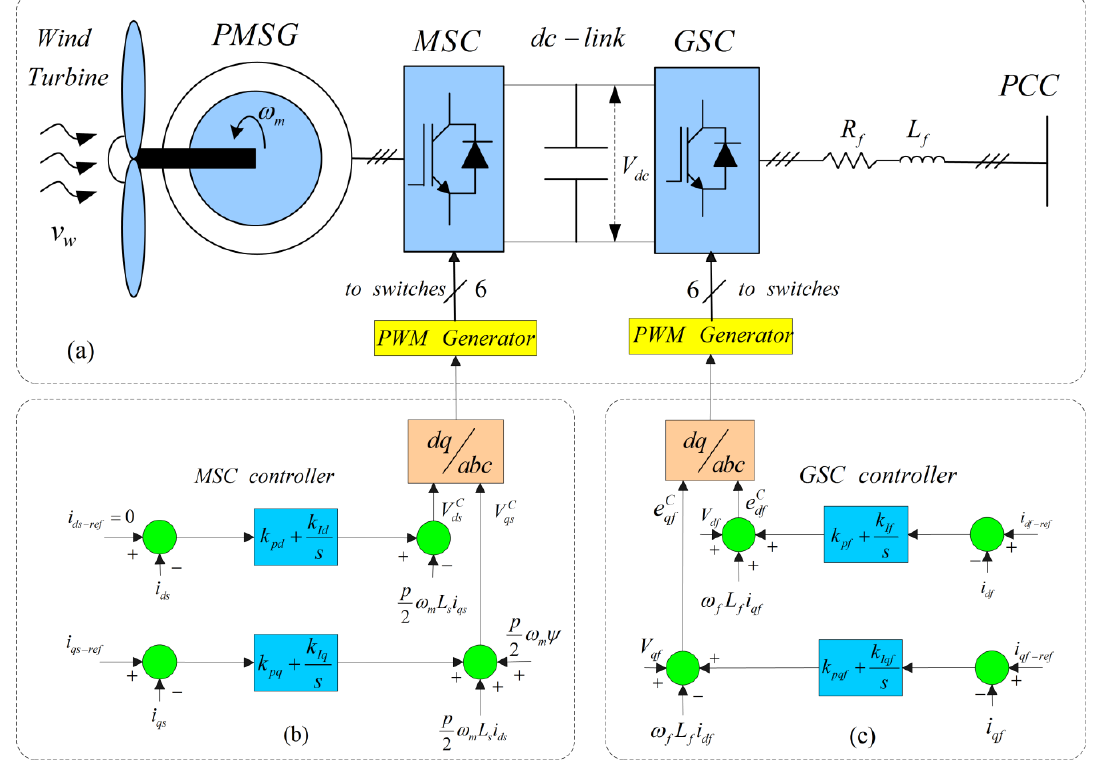
Figure 1. ( a ) PMSG-based wind turbine; ( b ) controller of MSC; and ( c ) controller of GSC.